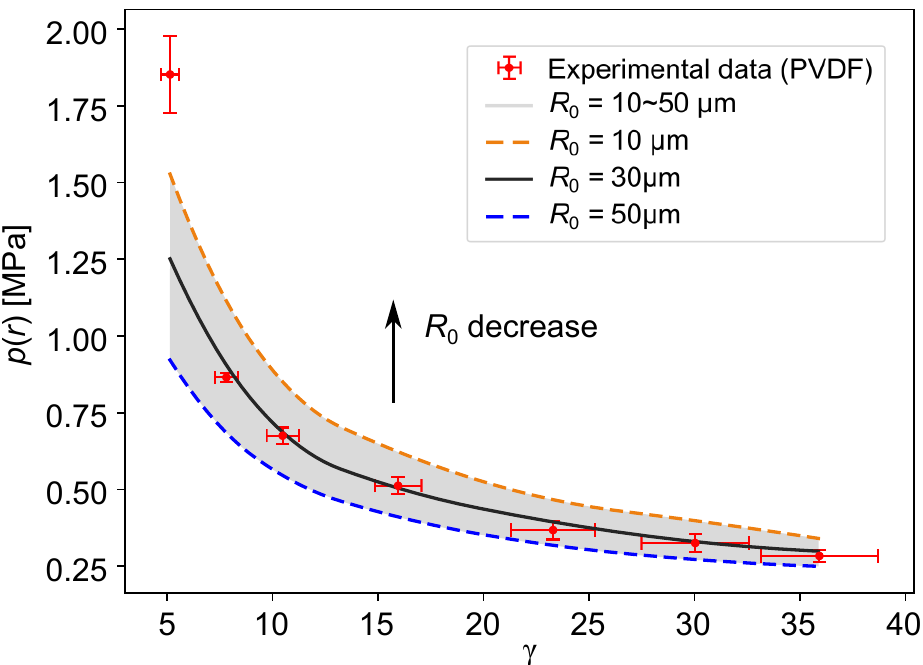
Figure 12. Comparison of the maximum values of the pressure wave of first collapse (red cross in Figure 5) and those predicted by the Gilmore analytical model p ( r ) for different d s with different R 0 . All the measurement values contain a uncertainty estimate with a 95% confidence